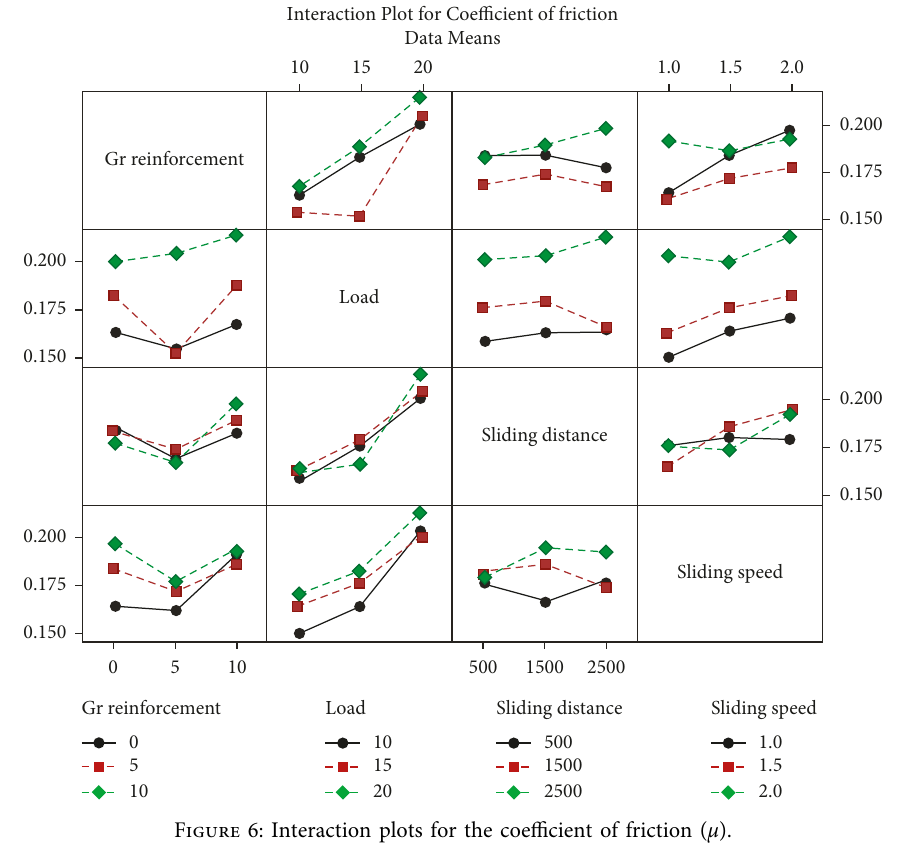
Figure 6: Interaction plots for the coefficient of friction ( µ ).